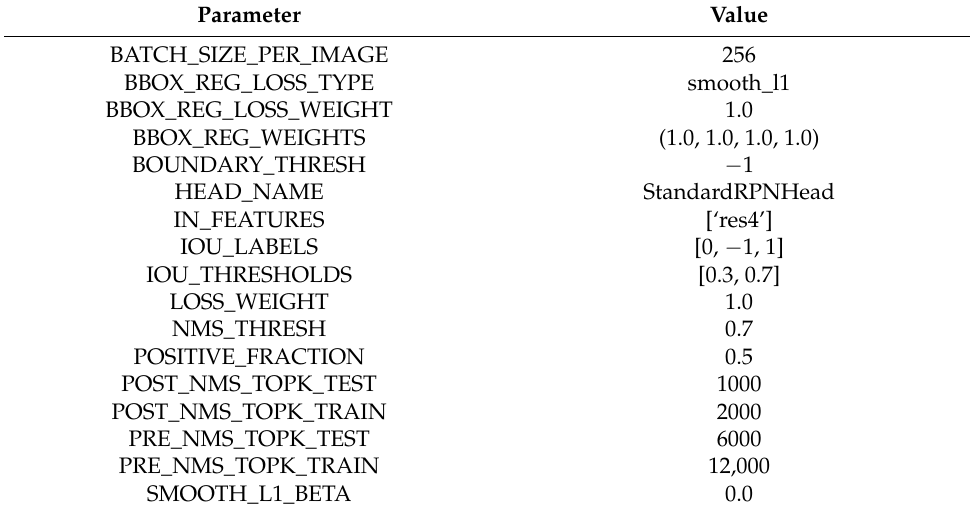
Table 1. RPN training parameters.